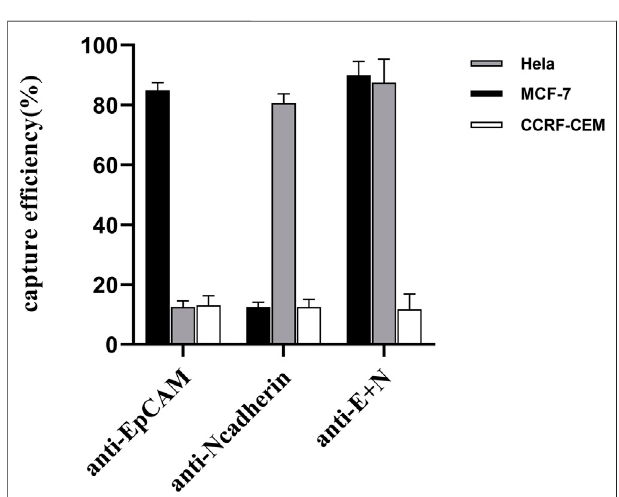
FIGURE 5 | Comparing the rates of capture ef fi ciency when using anti- EpCAM-modi fi ed, anti-N-cadherin-modi fi ed, and dual antibody-modi fi ed nanoparticles to capture model target cell